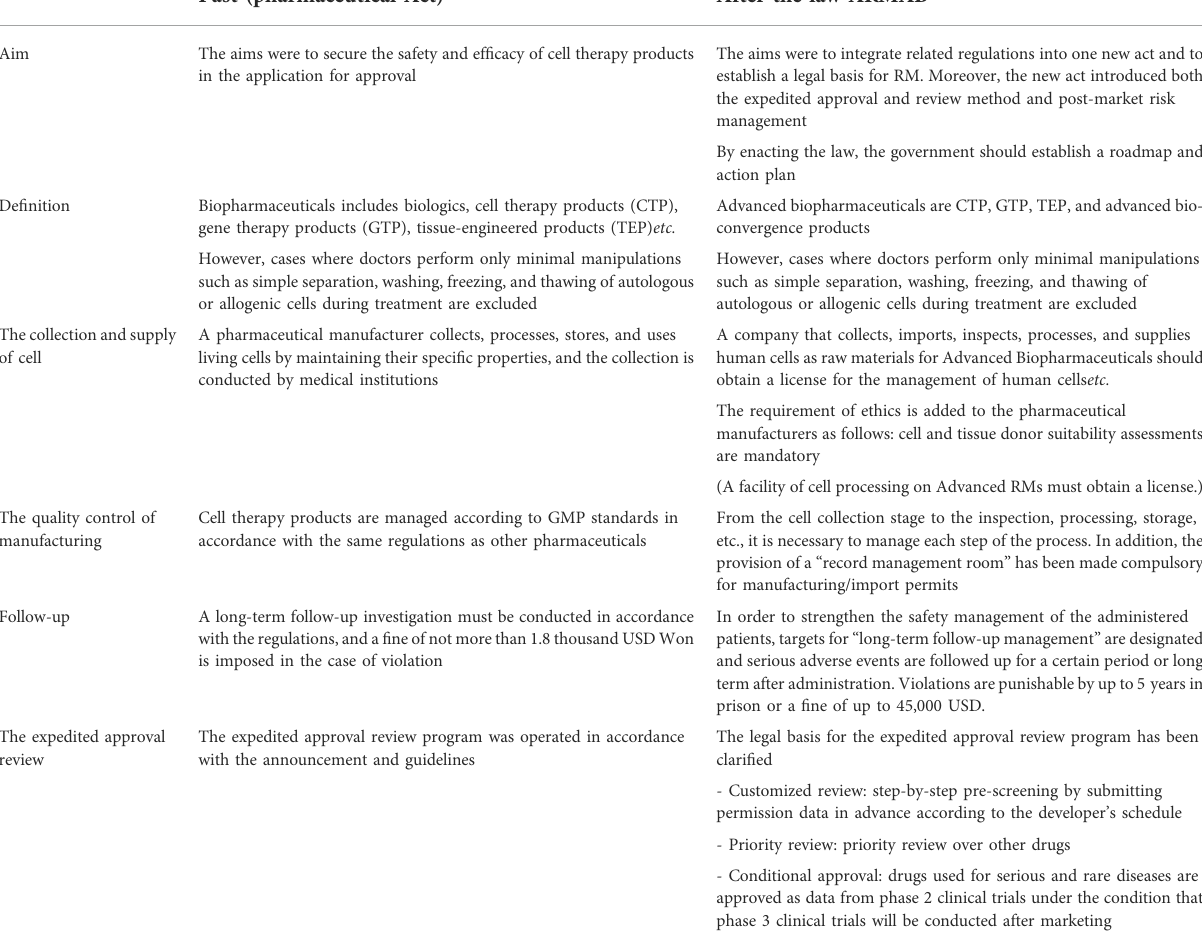
TABLE 4 Changes of advanced biopharmaceutical related regulation before and after ARMAB Act (MFDS, 2019; Ministry of Food and Drug Safety, 2020a; Ministry of Health and Welfare,